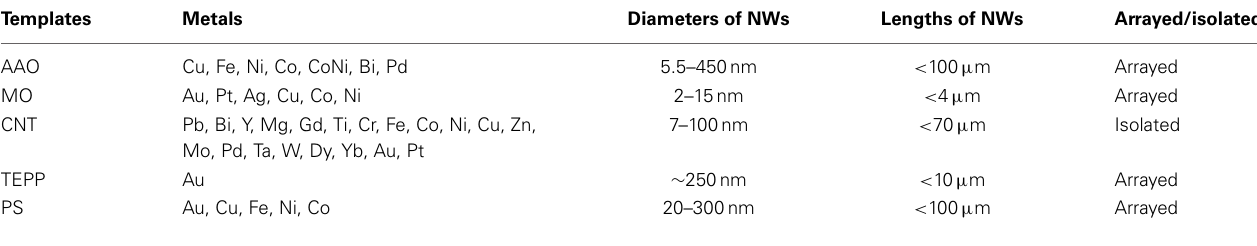
Table 1 | Comparison of NWs obtained using various hard templates.